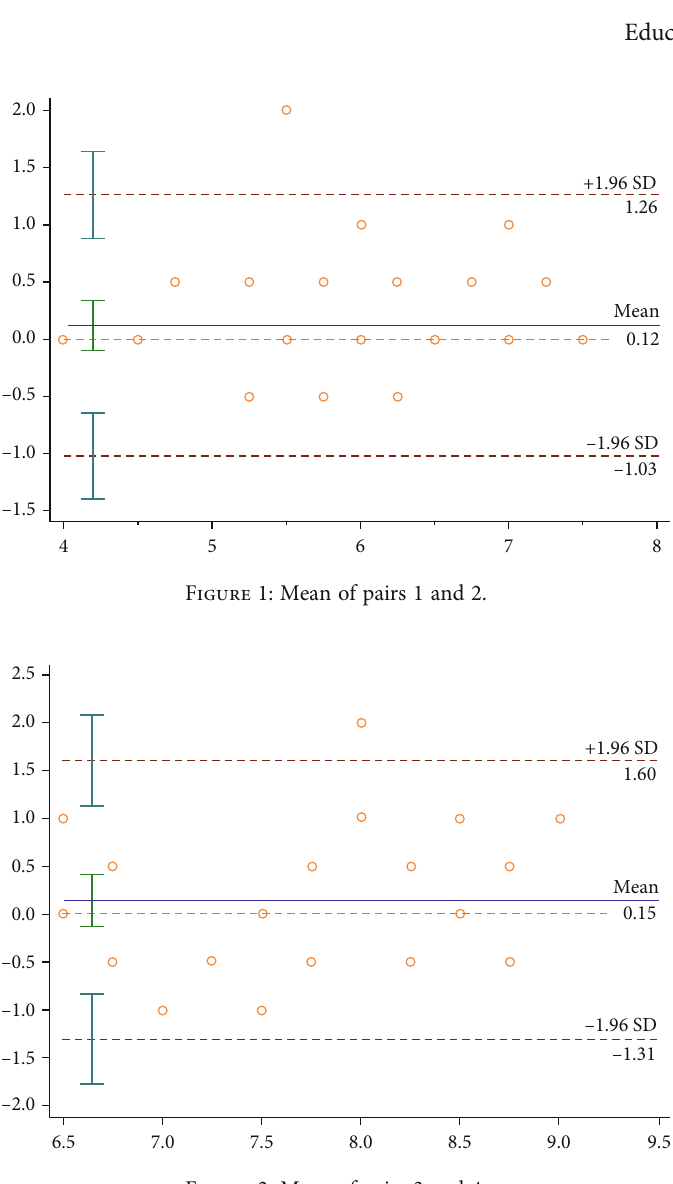
Figure 2: Mean of pairs 3 and